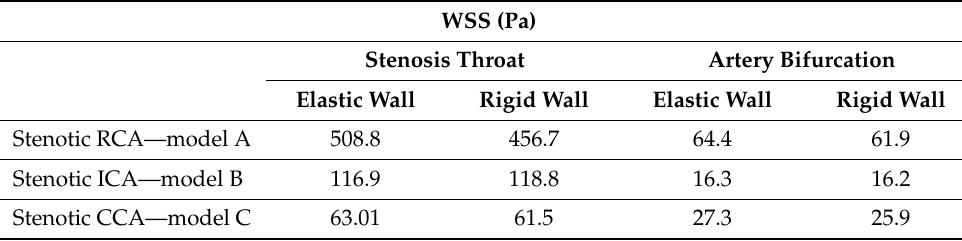
Table 2. WSS for the stenotic RCA and CA at the peak systole of the cardiac cycle elastic and rigid